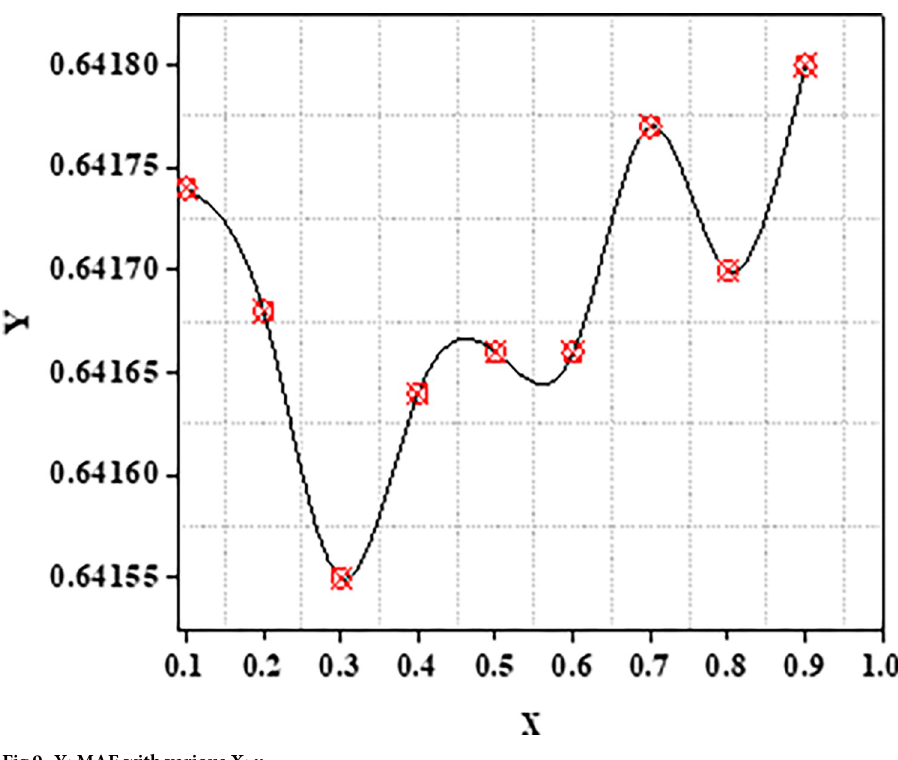
Fig 9. Y: MAE with various X: μ .